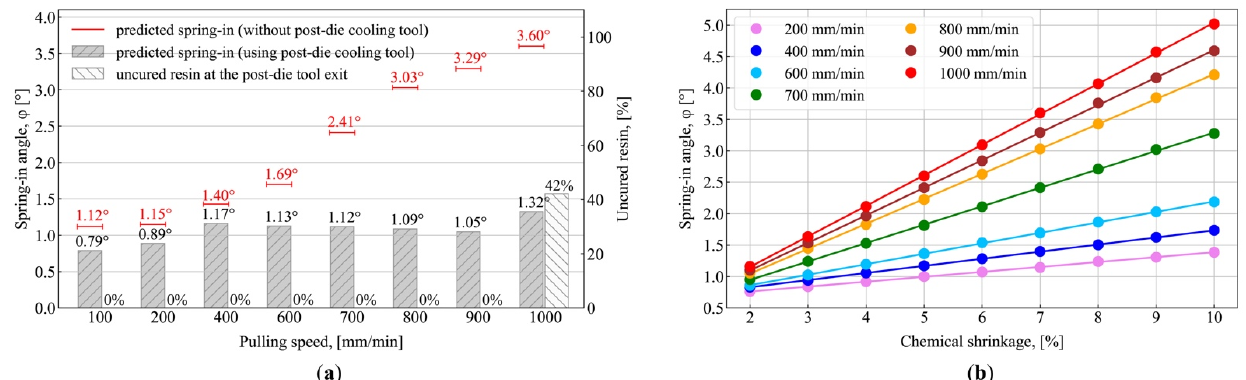
Figure 8. Simulation results for methods of spring-in reduction: ( a ) With the use of a post-die cooling tool. Gray columns mark the spring-in values obtained with the use of the post-die cooling tool; red lines indicate values obtained without the post-die cooling tool. The corresponding fraction of uncured resin ( α < 85%) is shown at the bottom of the graph; ( b ) Spring-in vs. chemical shrinkage of the resin at different pulling speeds (for shrinkage values within the range of 2 to 10%).